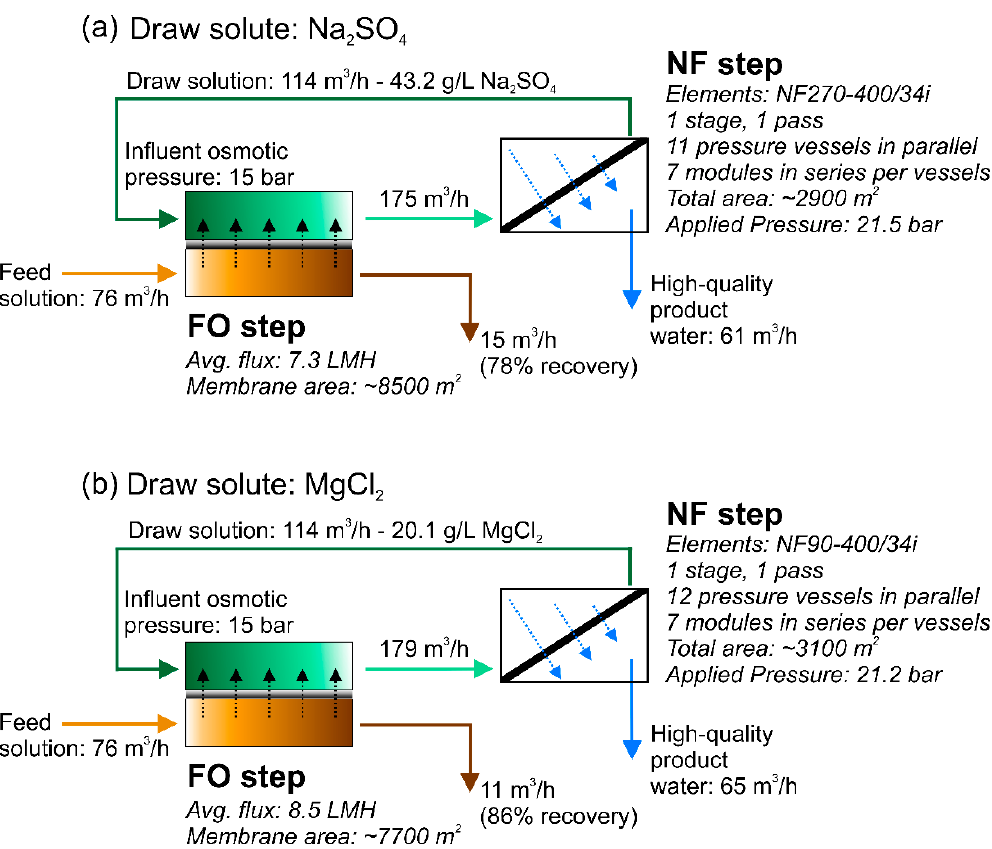
Figure 2. Configurations of the forward osmosis–nanofiltration hybrid system designed to treat real wastewater with ( a ) sodium sulfate and ( b ) magnesium chloride as the draw solute. The nanofiltration stage was designed to be operated with the NF270 and NF90 membranes, respectively [31].